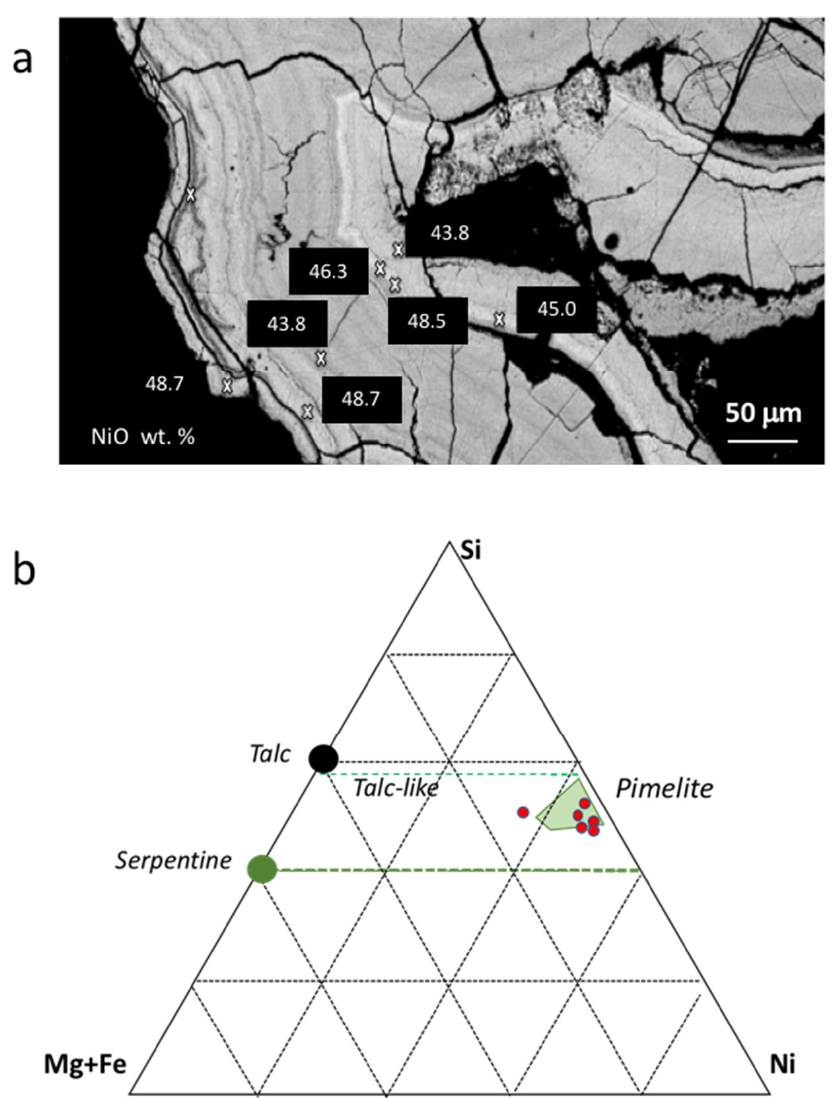
Figure 6. ( a ) Distribution of Ni (NiO%) in colloform pimelite. Each band has a high and relatively constant Ni concentration characterised by its speci fi c mean Z (average atomic weight). (NiO concentrations from EMPA). ( b ) Si-Mg + Fe-Ni diagram applied to electron microprobe analyses of pimelites from Koniambo compared to pimelite from other New Caledonian sites (domain in green for other Caledonian deposits such as Thio and Poro, unpublished data). The reference line for talc-like solid-solution has already been proposed by [23,44].